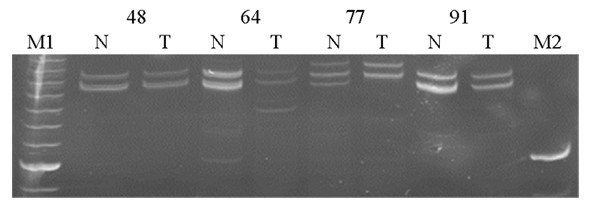
Loss of heterozygosity study at D3S3522 polymorphic marker in neuroblastic tumors. PCR products were run in a 15% polyacrylamide gel and visualized after ethidium bromide staining (0.5 μg/ml) T: DNA from tumor tissue; N: DNA from peripheral blood of the same patient; M1/M2: 10 bp DNA ladder/1 Kb Plus DNA ladder (Invitrogen™ Life and Technologies, Carlsbad, CA, USA). Sample number 64 showed microsatellite instability.